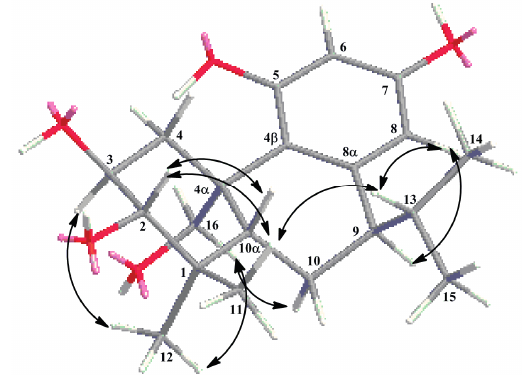
Figure 3. Key ROESY correlations of compound 1